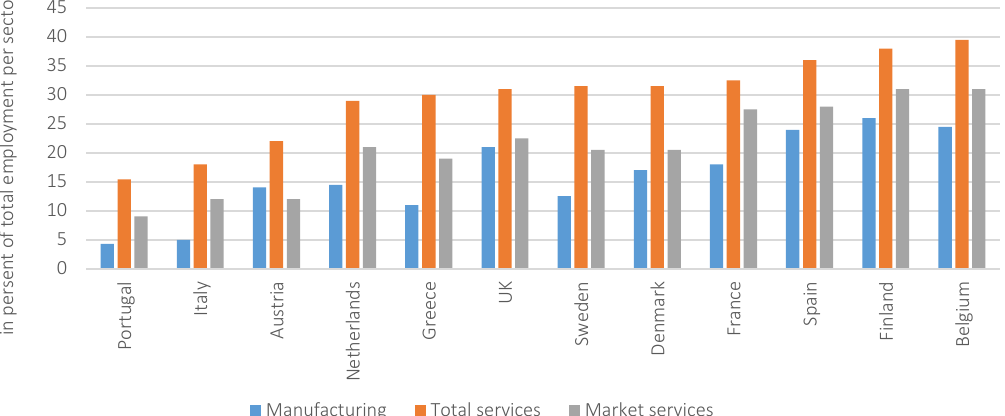
Figure 10. Share of high-skilled employment in total employment per sector, 2002